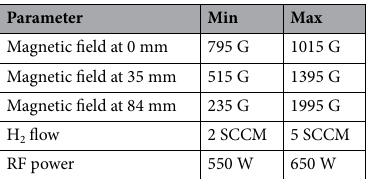
Table 1. Ranges of source configuration parameters tested during the